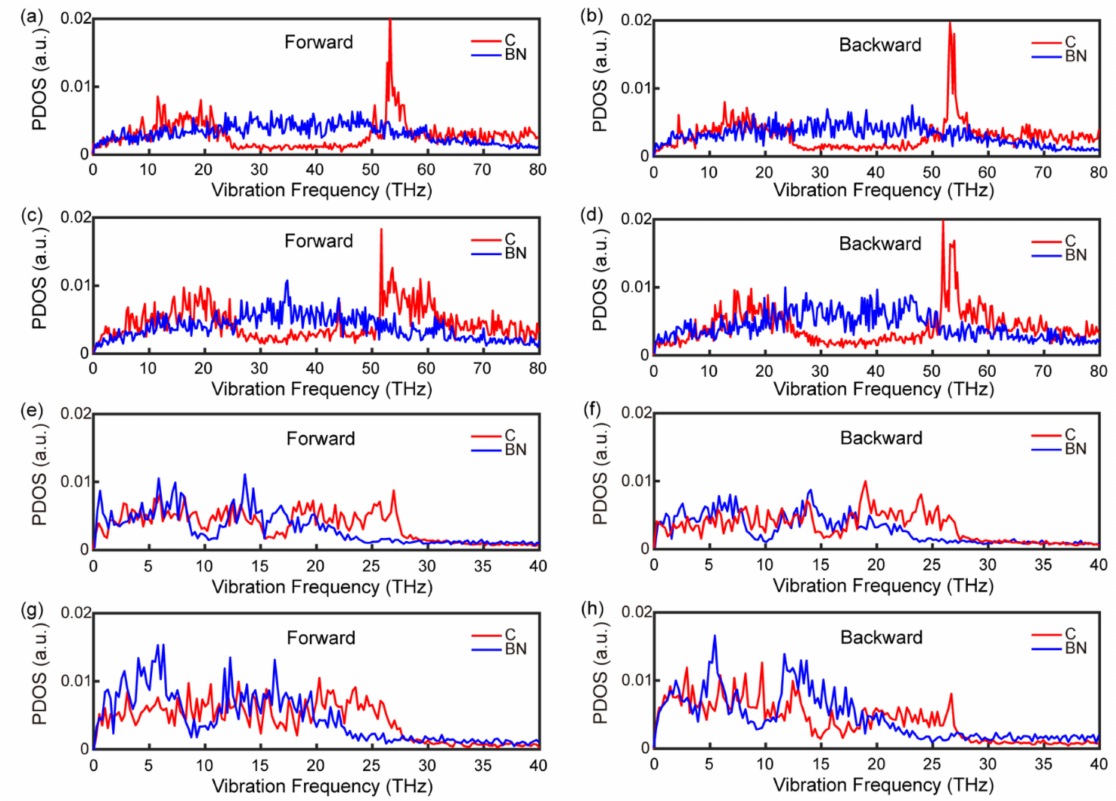
Figure 2. The PDOS curves of carbon (C) and boron nitride (BN) atoms in the forwards and backwards directions. ( a , b ) in-plane direction in the middle (a unit of atoms in the middle region of pure C/BN); ( c , d ) in-plane direction at the interface; ( e , f ) out-of-plane direction in the middle; ( g , h ) out-of-plane direction at the